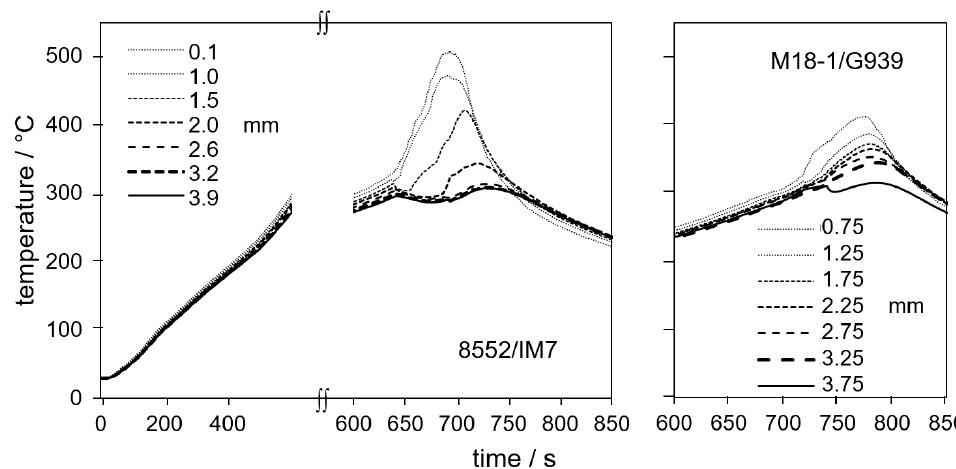
Figure 8. Exemplary temperature rises in various depth of 4 mm thick 8552/IM7 and M18-1/G939 CFRP panels with integrated thermocouples during application of 40 g fire accelerant.